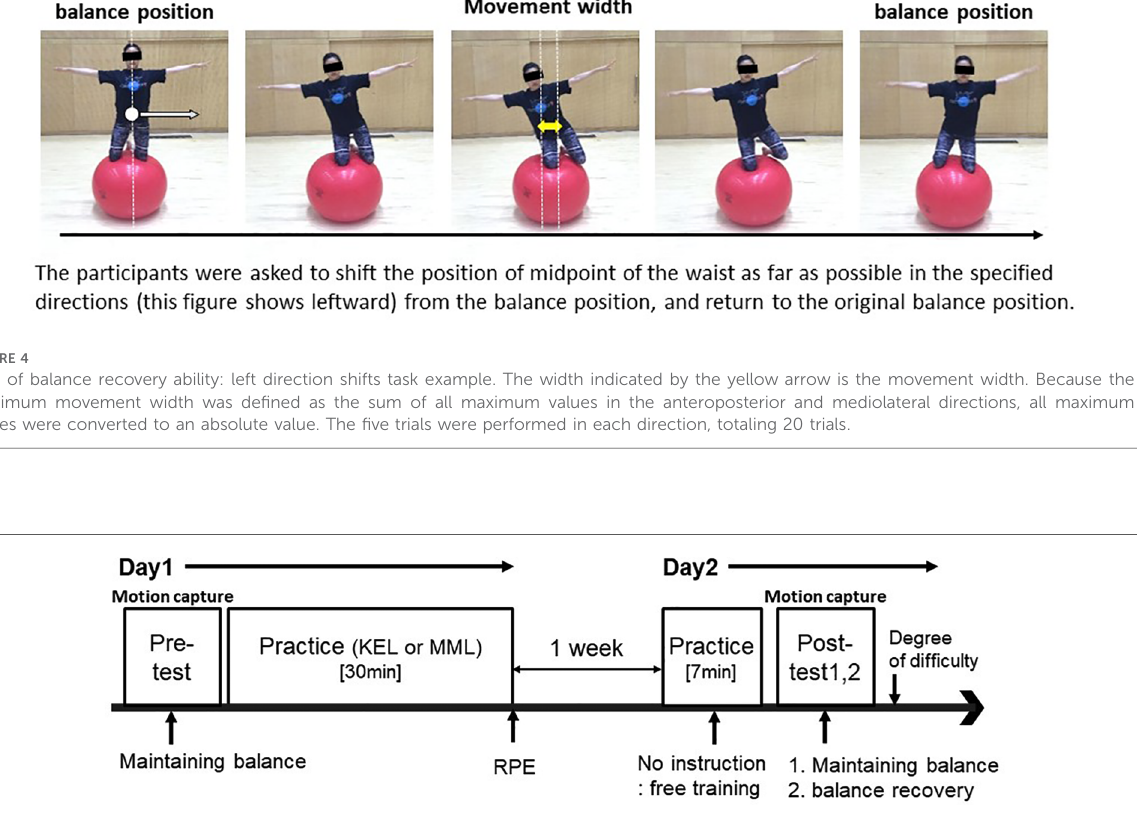
FIGURE 5 Experimental protocols. First, the participants performed a pre-test on maintaining balance using motion capture before practice was conducted. The participants were randomly divided into two groups (the KEL method and the MML method), and 30 min of balancing practice were conducted according to each learning method. The participants then responded to the RPE after the practice session. After 1 week, a second practice session was conducted for 7 min. After that, a post-test of maintaining balance was performed using motion capture. After the measurement, the test of balance recovery ability was presented, and a measurement was performed by motion capture without any practice